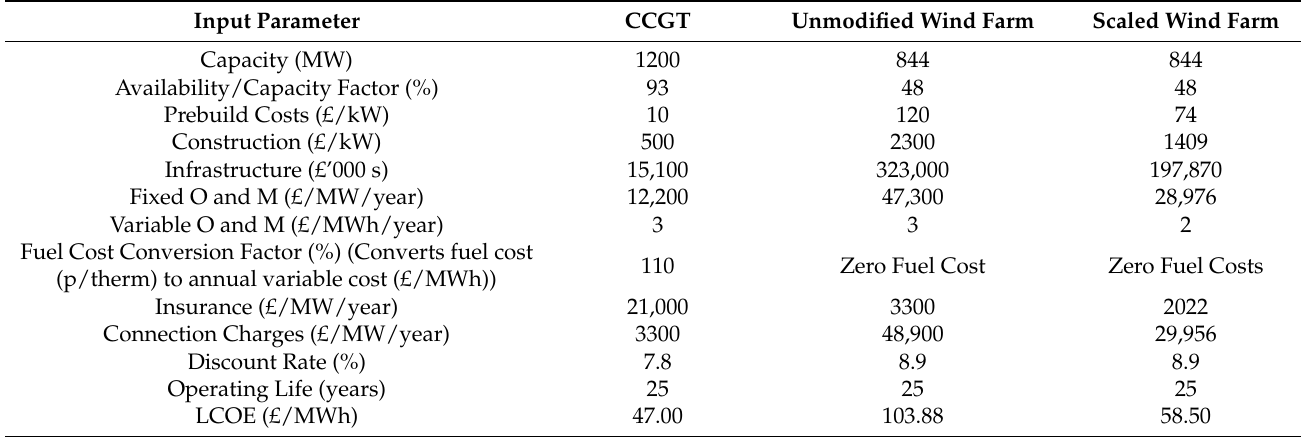
Table 5. Parameter Calculation according to Williams and Rubert